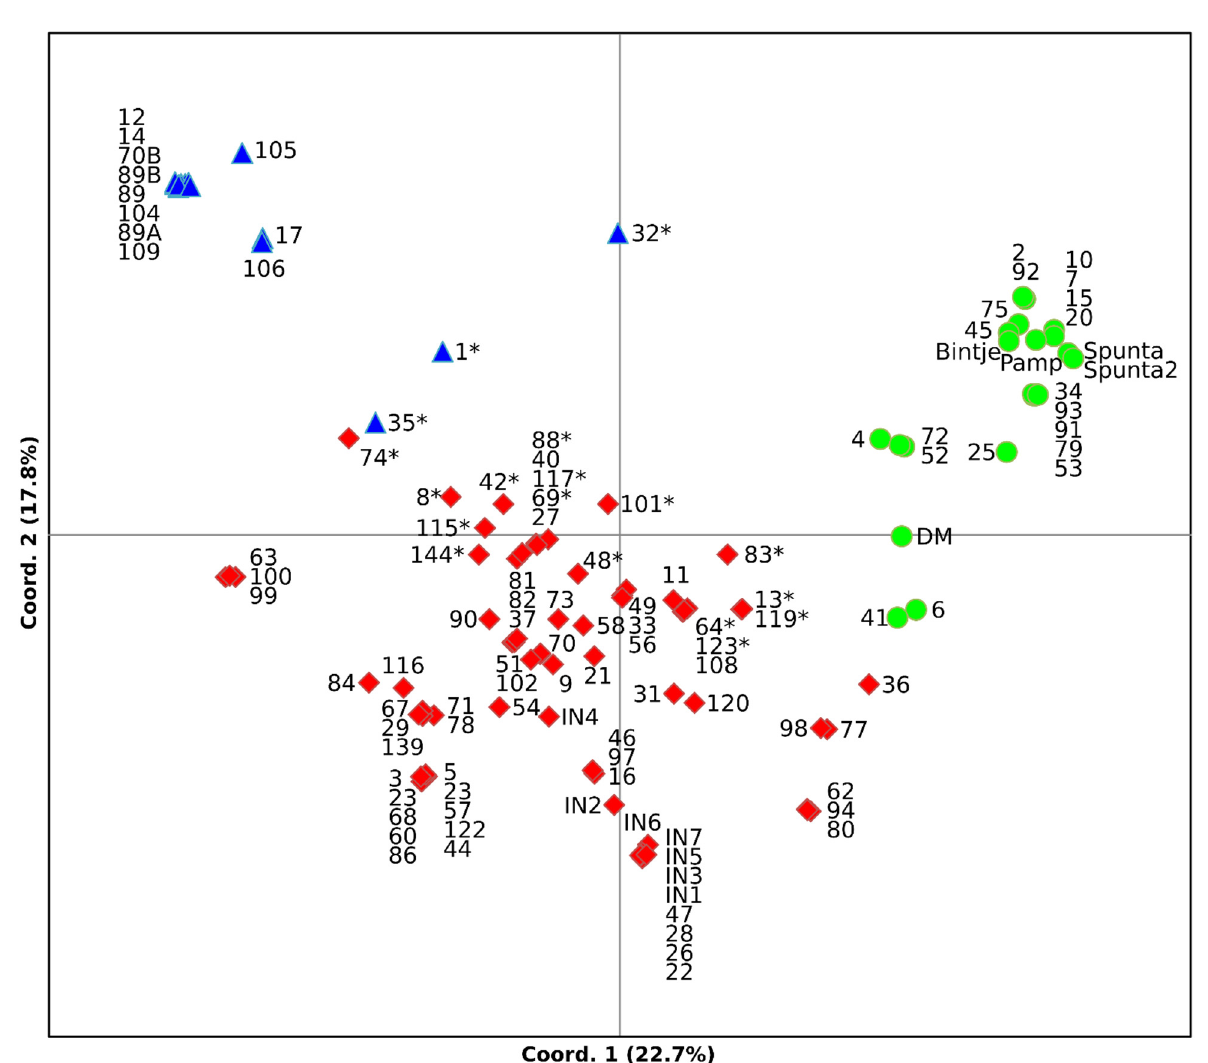
Figure 4. Principal coordinate analysis (PCoA) of the 114 potato accessions in the panel based on 5035 DArTseq markers. Color coding corresponds to colors used for the STRUCTURE grouping assignment. Accessions with a membership proportion lower than 0.6 are labeled with an asterisk. Numbers in parentheses in the axes depict the percentage of genetic variance.